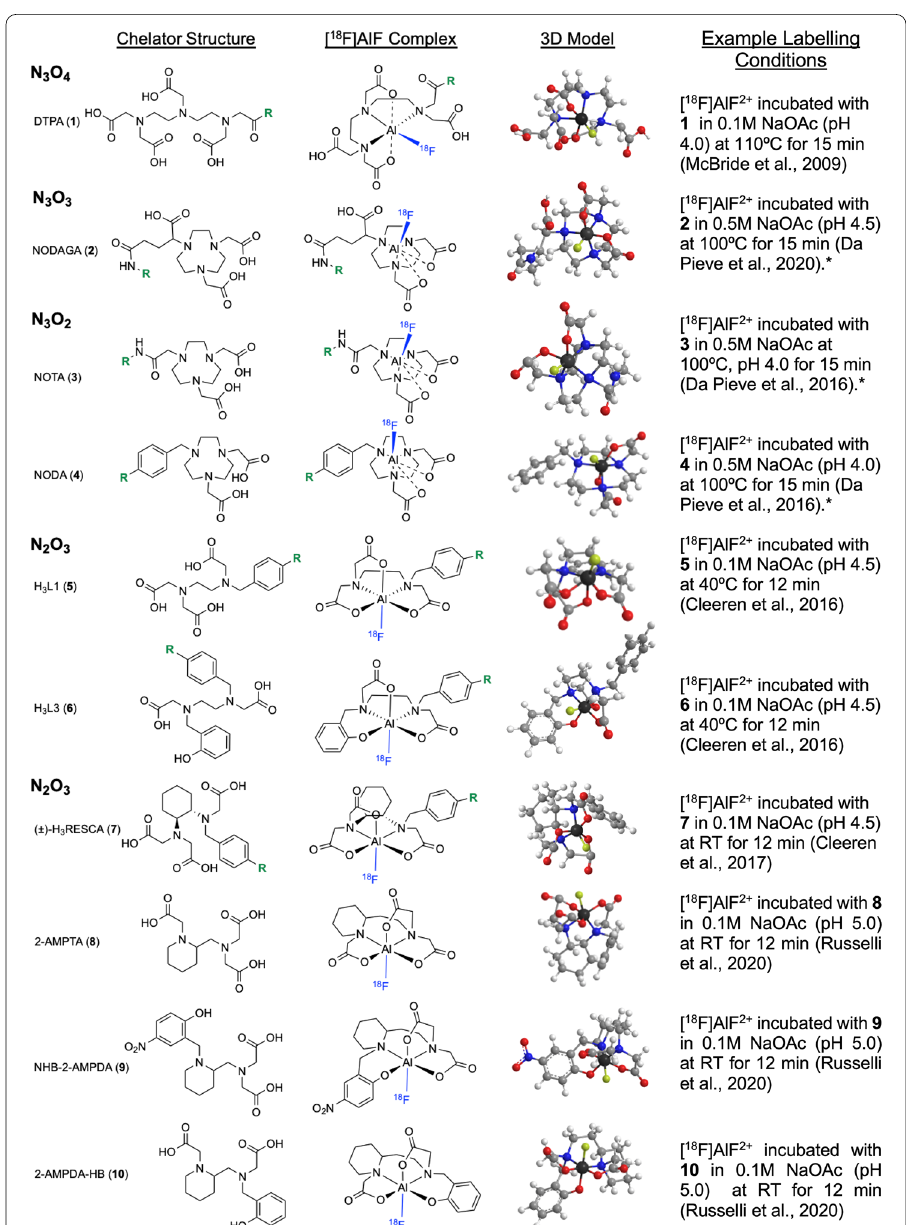
Fig. 3 Structures of chelators evaluated for [ 18F]AlF and their proposed complexes. R bioconjugation = handle. 3D models were created in ChemBio3D (Cambridgesoft, UK) with MM2 energy minimization applied. Atom colours: carbon light grey, hydrogen white, oxygen red, nitrogen blue, fuorine yellow, = = = = = aluminium dark grey. RT room temperature. *Optional 1:1 (v/v) co-solvent included in the reaction = = mixture to improve